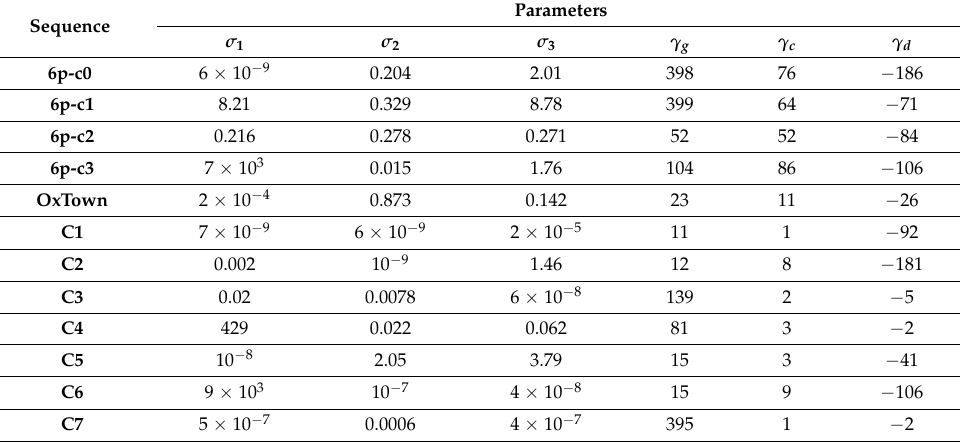
Table 1. The proposed system smoothing and tracking optimized parameters for each utilized video